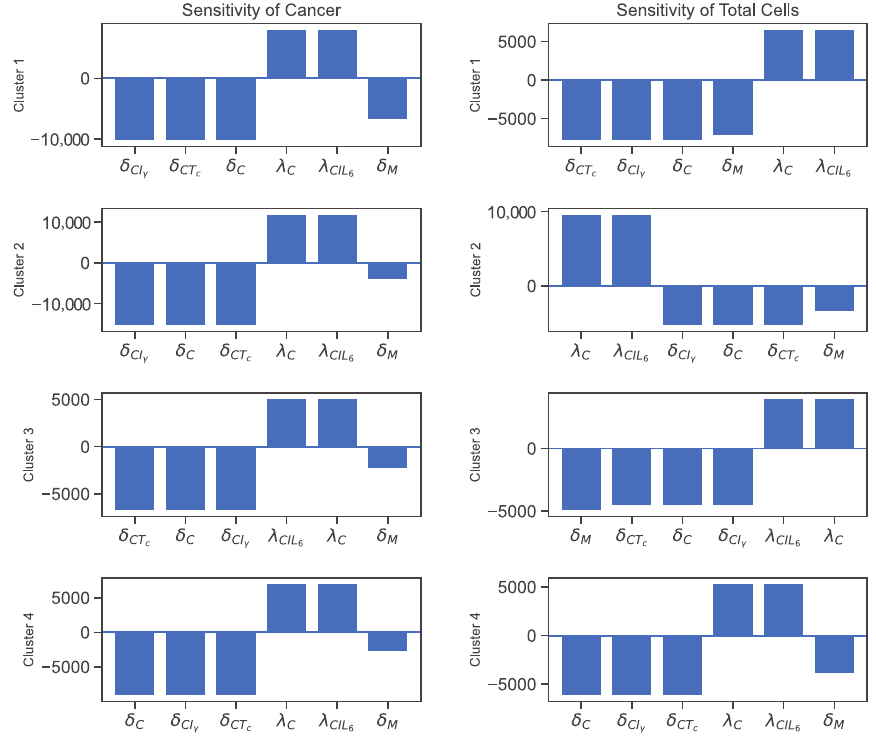
Figure 4. Sensitivity analysis results for cancer and total